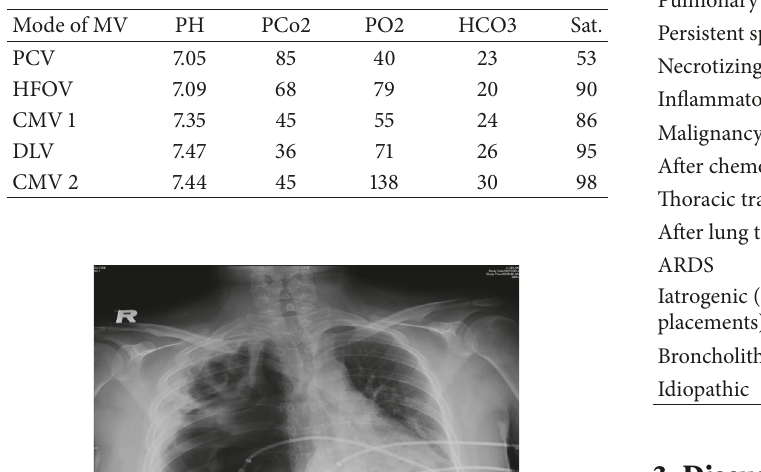
Table 1: Blood gas change on different modes of mechanical ventilation.